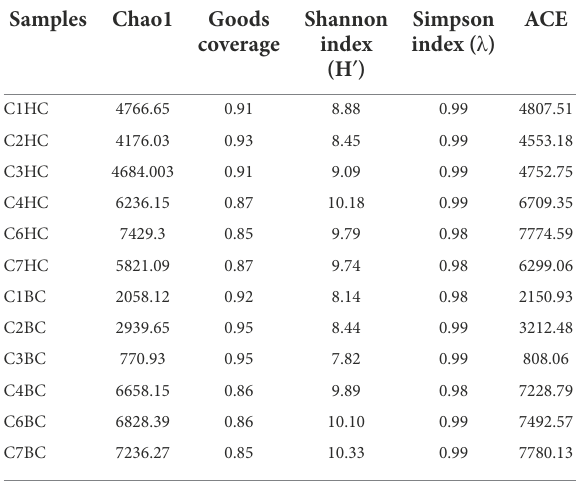
TABLE 2 Alpha diversity indices for H 2 + CO 2 (designated as C1–C7 HC) and HCO 3 − (are designated as C1–C7 BC) enrichment samples.